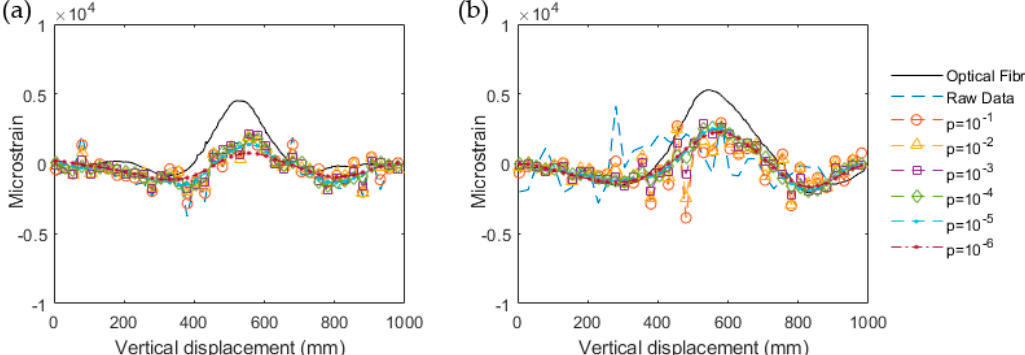
Figure 8. OOP deformation test Step 2: Strain along the vertical line ( a ) at 800 mm and ( b ) at 1000 mm for different p parameters, no filter, and optical fibre.